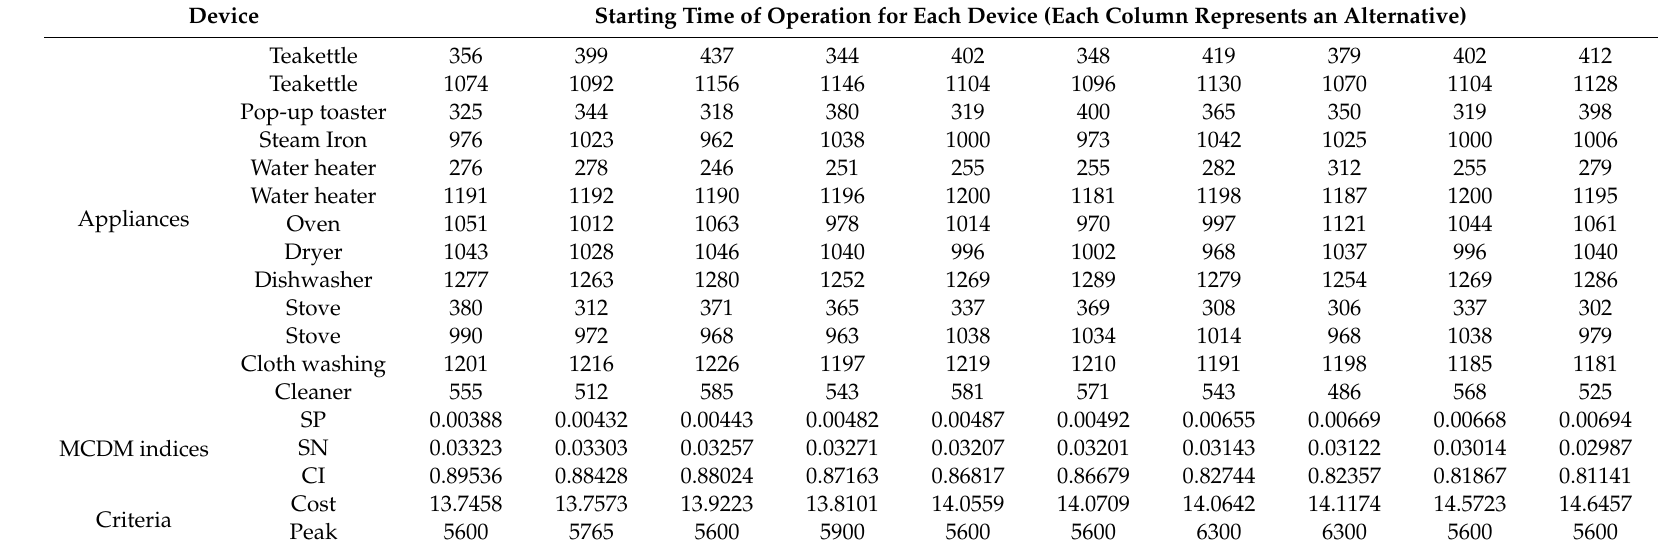
Table 7. Scores based on integrated analytic hierarchy process-technique for order preferences by similarity to ideal solution (AHP-TOPSIS) for first developer.